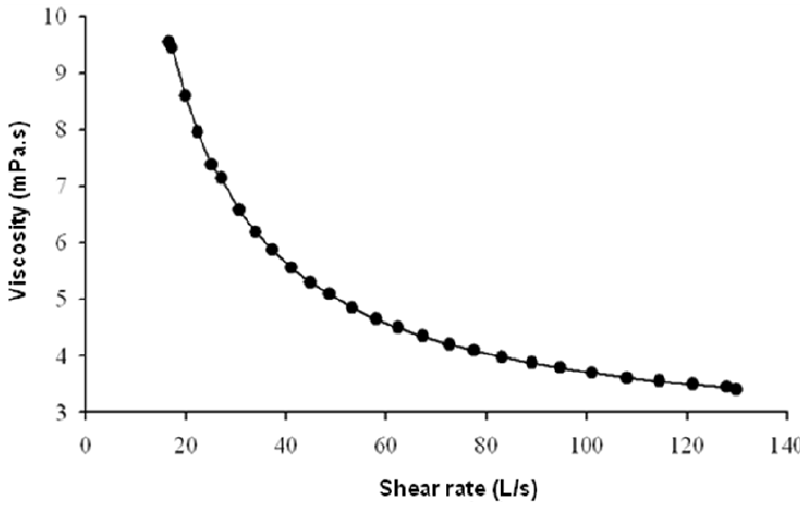
Figure 4. Viscosity of 0.5% w/v solutions of EPS (fractions A and B) synthesised by H. almeriensis M8 T .